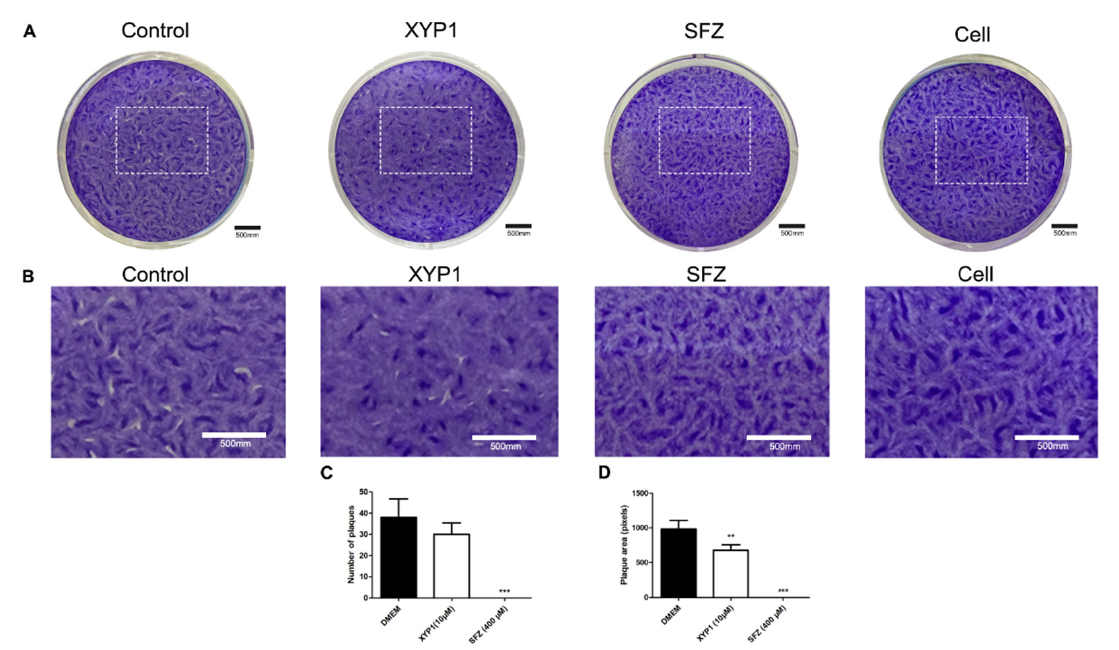
Figure S2. Plaque assay. HFFs were infected with tachyzoites and treated with DMEM (negative control), XYP1 (10 µ M) and SFZ (positive control, 400 µ M), respectively, for 7 days. ( A ) Photos of representative wells. ( B ) Magnified zones of plaques graphs. ( C ) The number of plaques determined manually. ( D ) Plaque area determined by Photoshop CS7. The means were determined by values obtained from three independent experiments (Student’s two-tailed t test). ** p < 0.01 and *** p < 0.001 compared with the negative control. Scale bars = 500